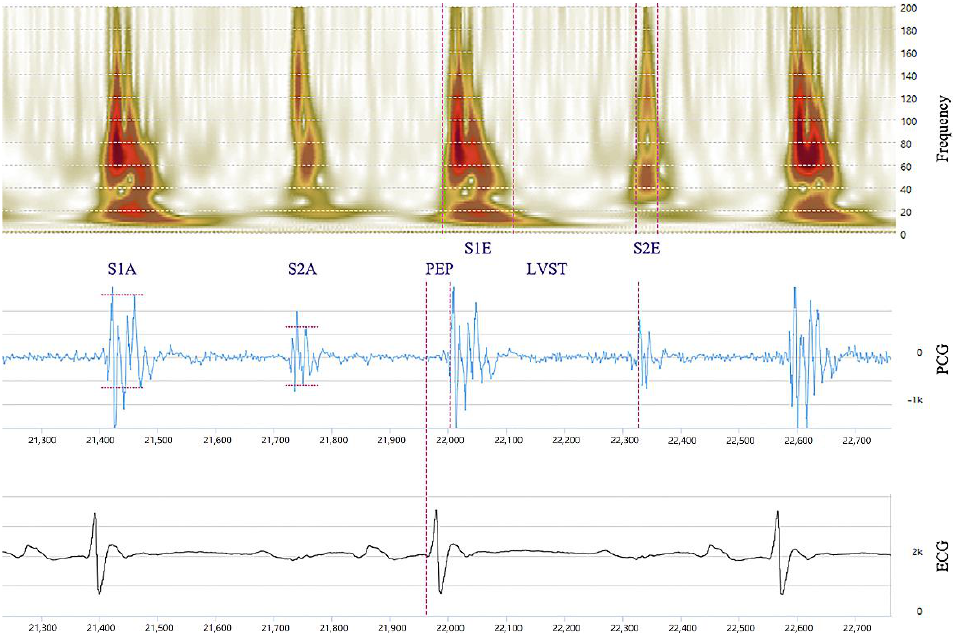
Figure 3. The parameters measured are marked on a combination of ECG, PCG, and frequency: the first sound amplitude (S1A); the first sound energy (S1E); PEP (the time period from the start of the ECG Q peak to the S1E peak); the second sound amplitude (S2A); the second sound energy (S2E); LVST (the time period from the start of the S1E peak to the S2E peak).